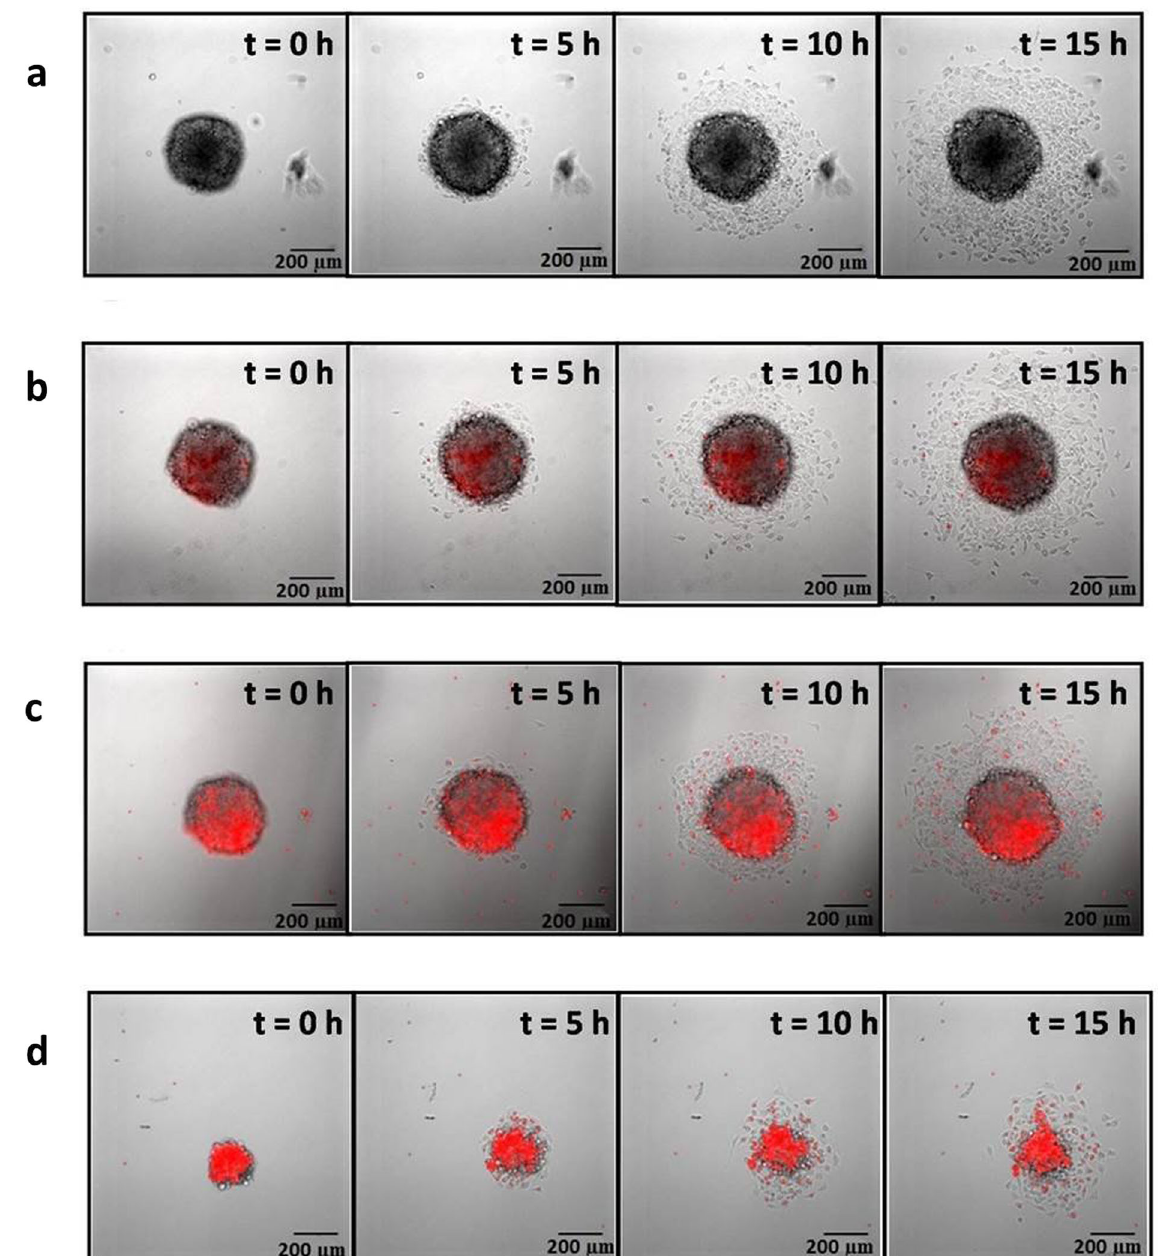
Fig. 6 Spreading of hybrid aggregates for different volume fractions of fl uorescent microparticles. a The spreading of cell aggregates without microparticles (MPs) as a function of time (volume fraction Ф V = 0). b – d The spreading of cell aggregates as a function of time with Ps-10 MPs (red) volume fractions fi xed at Ф V = 0.1, 0.25, and 0.5 respectively. We notice that the microparticles are not uniformly distributed and segregation increases with Ф V